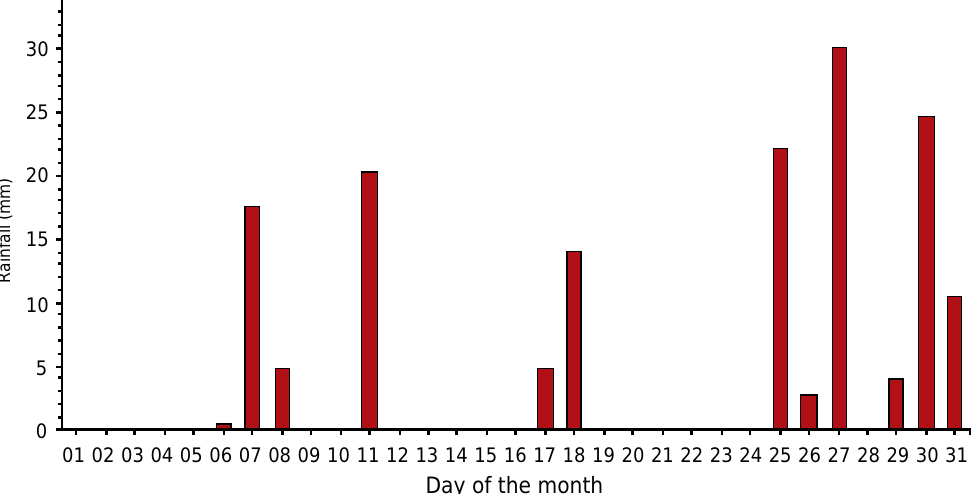
Figure 1. Distribution of rainfall in the region in July 2012, the month of the forest harvest. Source: INMET